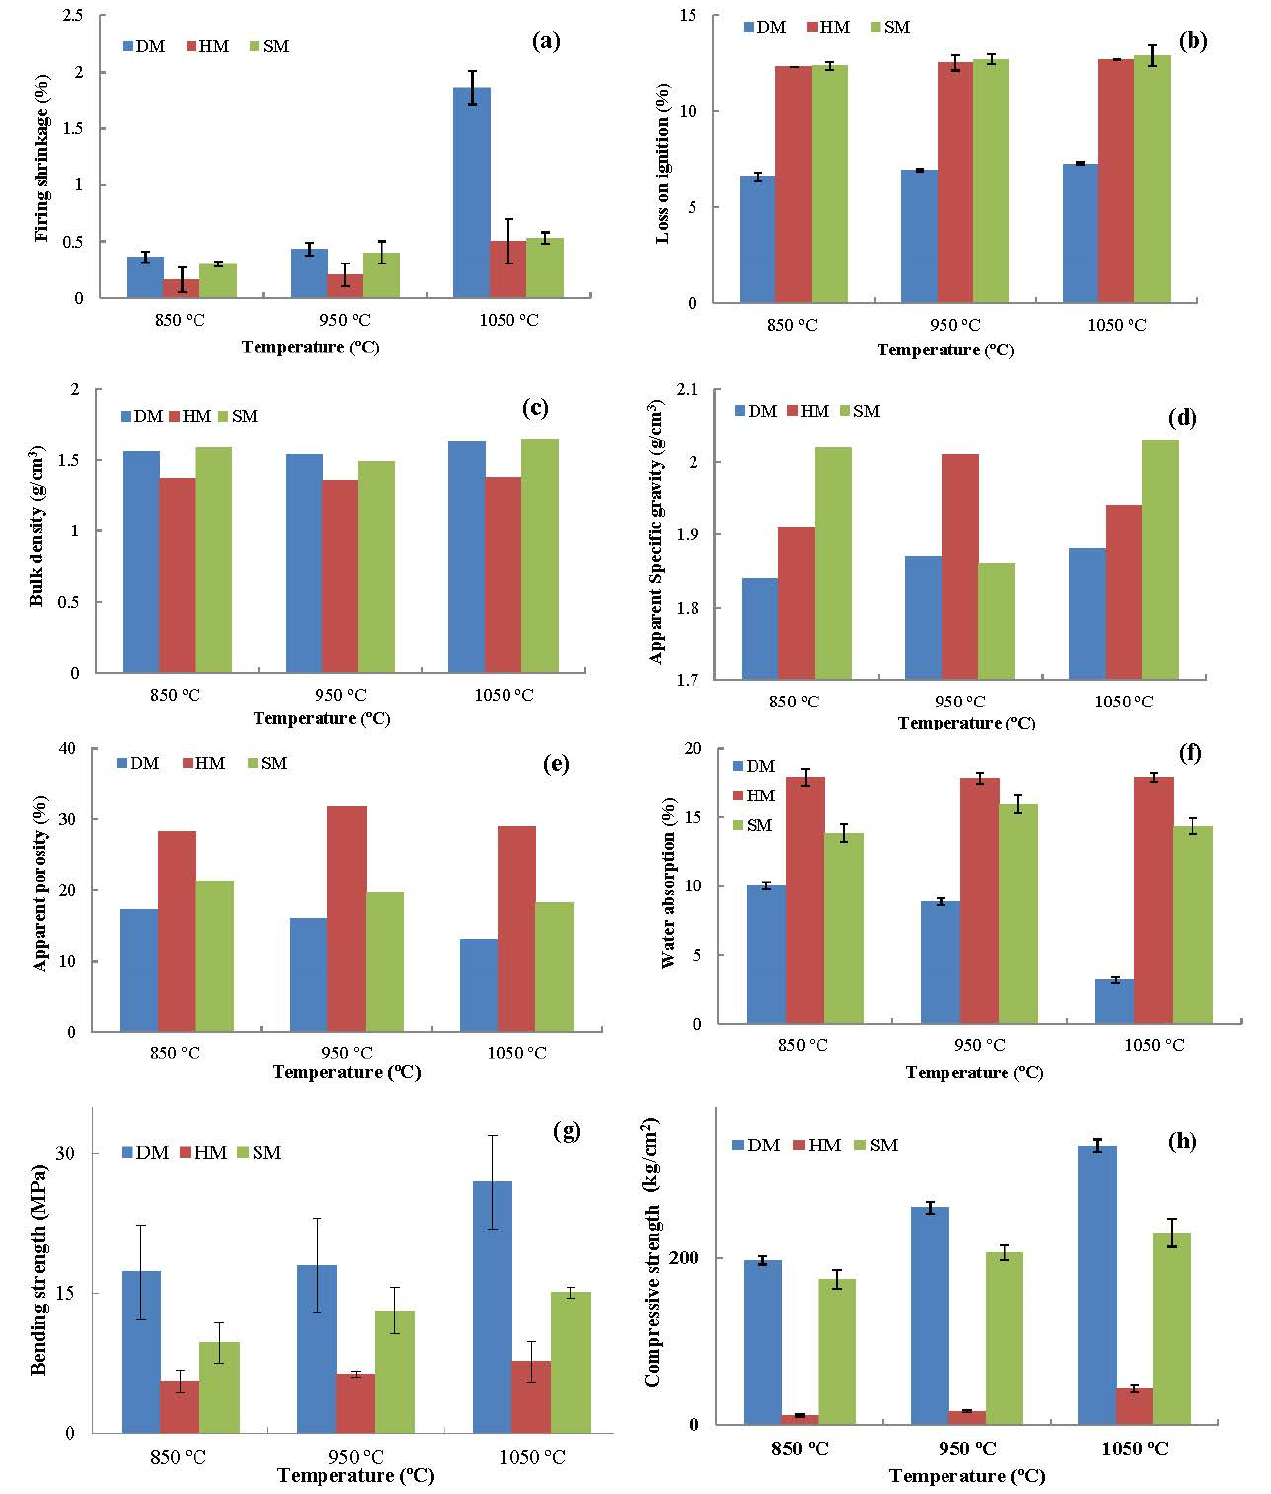
Figure 10. Results of the technological parameters according to the fired temperatures (850 ◦ C, 950 ◦ C, and 1050 ◦ C) of DM, HM, and SM brick specimens: ( a ) firing shrinkage (%), ( b ) loss on ignition (%), ( c ) bulk density, ( d ) apparent specific gravity, ( e ) apparent porosity (%), ( f ) water absorption (%), ( g ) bending strength (MPa), ( h ) compressive strength (kg/cm 2 ). The apparent porosity values of the DM, HM, and SM clay-based brick specimens are given in Figure 10e. The brick specimens fired at 1050 ◦ C displayed lower apparent